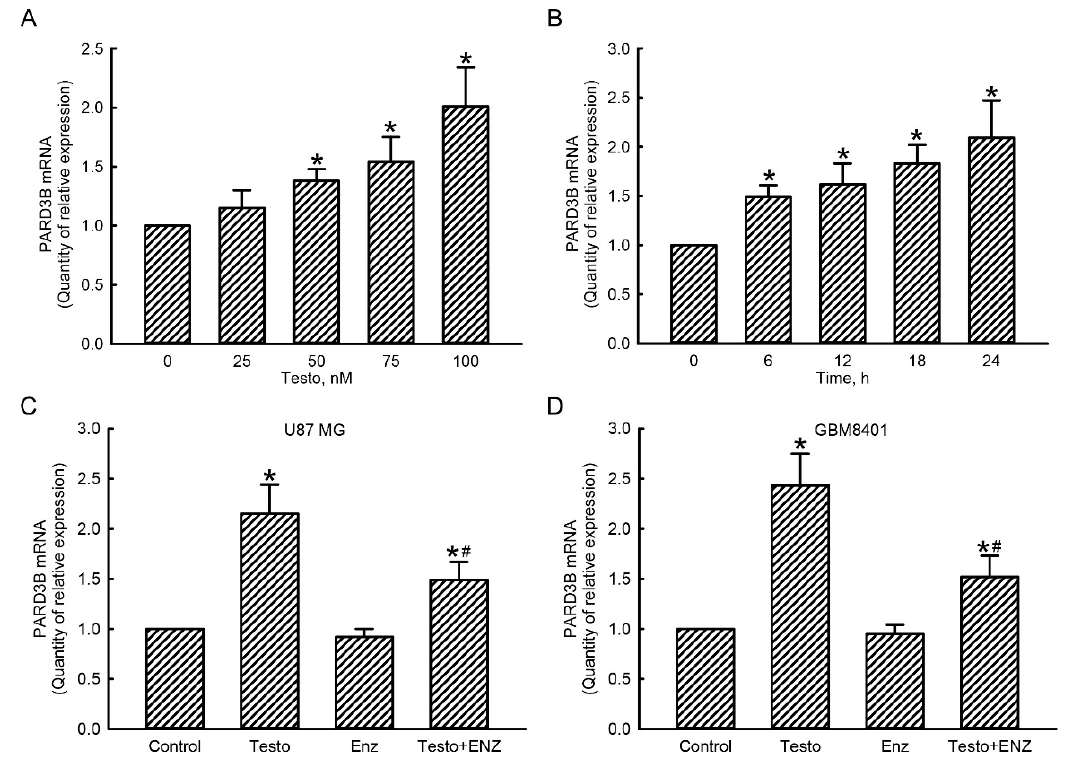
Figure 4. Involvement of the androgen receptor (AR) in regulation of PARD3B gene expression in glioblastoma cells. Human U87 MG glioblastoma cells were treated with testosterone (Testo) at 25, 50, 75, and 100 nM for 24 h ( A ) or at 100 nM for 6, 12, 18, and 24 h ( B ). Human U87 MG ( C ) and GBM8401 ( D ) glioblastoma cells were pretreated with 10 µ M enzalutamide (Enz) for 1 h and exposed to 100 nM Testo for 24 h. Total RNA was extracted for a real-time PCR analysis of AR mRNA. Each value represents the mean ± standard error of the mean for n = 6. The symbols * and # indicate that values significantly ( p < 0.05) differed from the control and testo-treated groups, respectively.